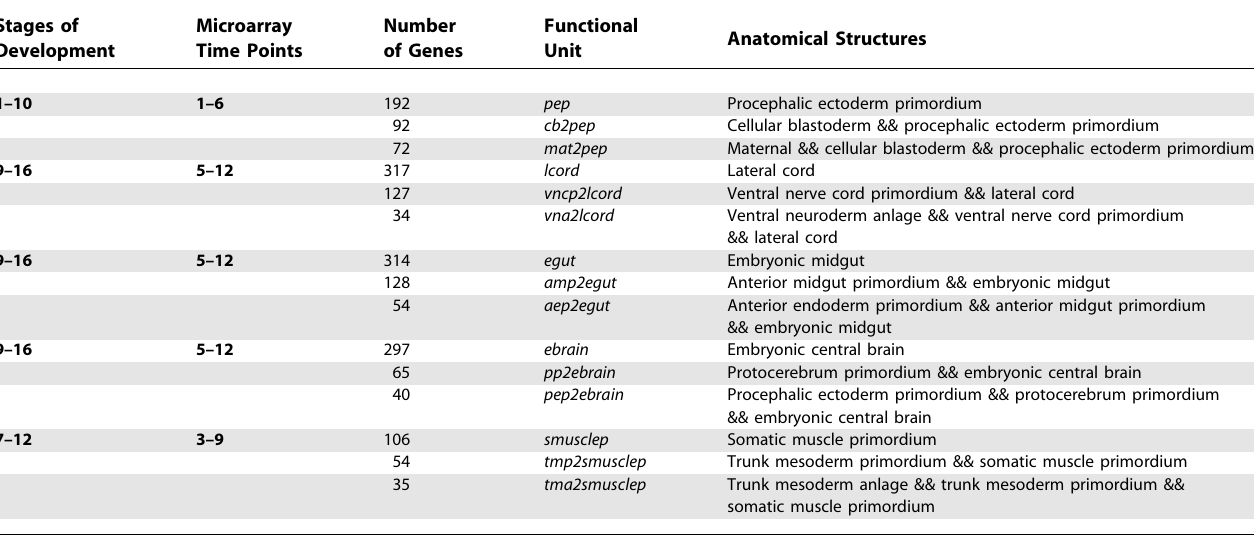
Table 1. Functional Units Assembled To Predict the Localization of Expression in Drosophila Embryogenesis Stages of